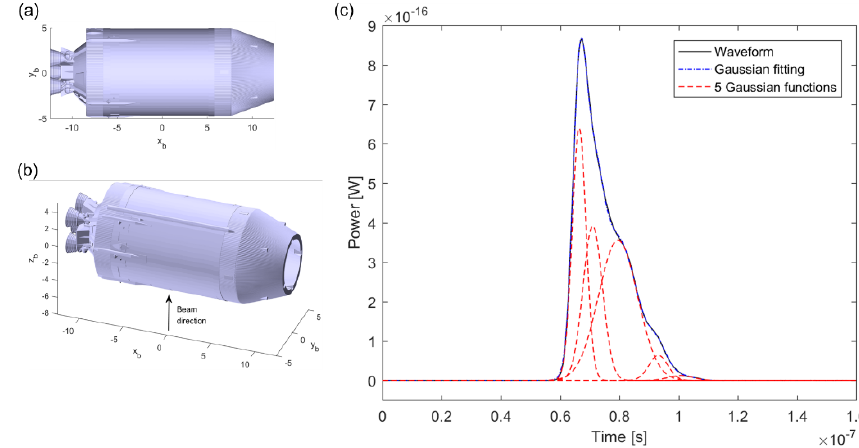
Figure 10. The ( a ) reflected surface, ( b ) orientation of rocket body, and ( c ) the echo waveform and 5 Gaussian functions obtained from the Gaussian decomposition for no rotation w.r.t. Figure 2b.